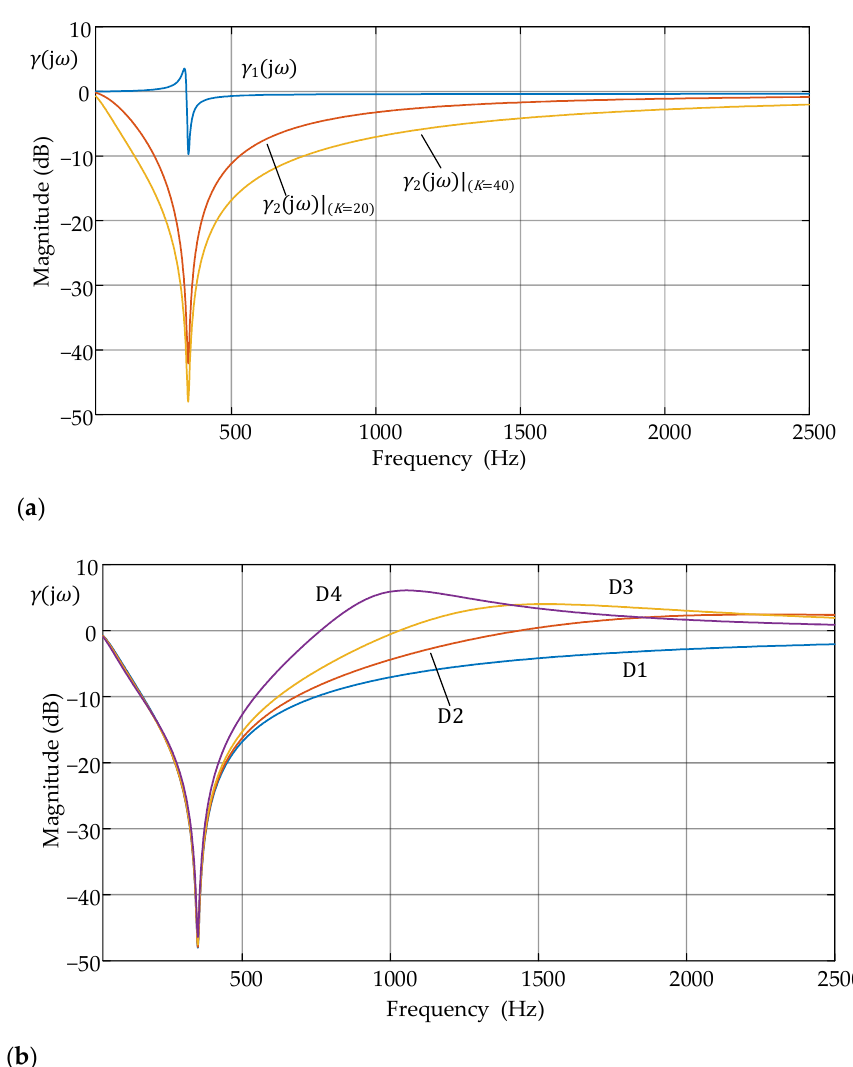
Figure 5. Harmonic attenuation rate of HAPF: ( a ) ideal operation condition (no time delay), passive filter PF ( γ 1 ), HAPF with CL1 ( γ 2 ), K = 20 and K = 40; ( b ) operation of HAPF with CL1 ( γ 2 ) and K = 40 for different values of time delay, D1— T D = 0 μs, D2— T D = 75 μs, D3— T D = 150 μs, D4— T D = 300 μs.